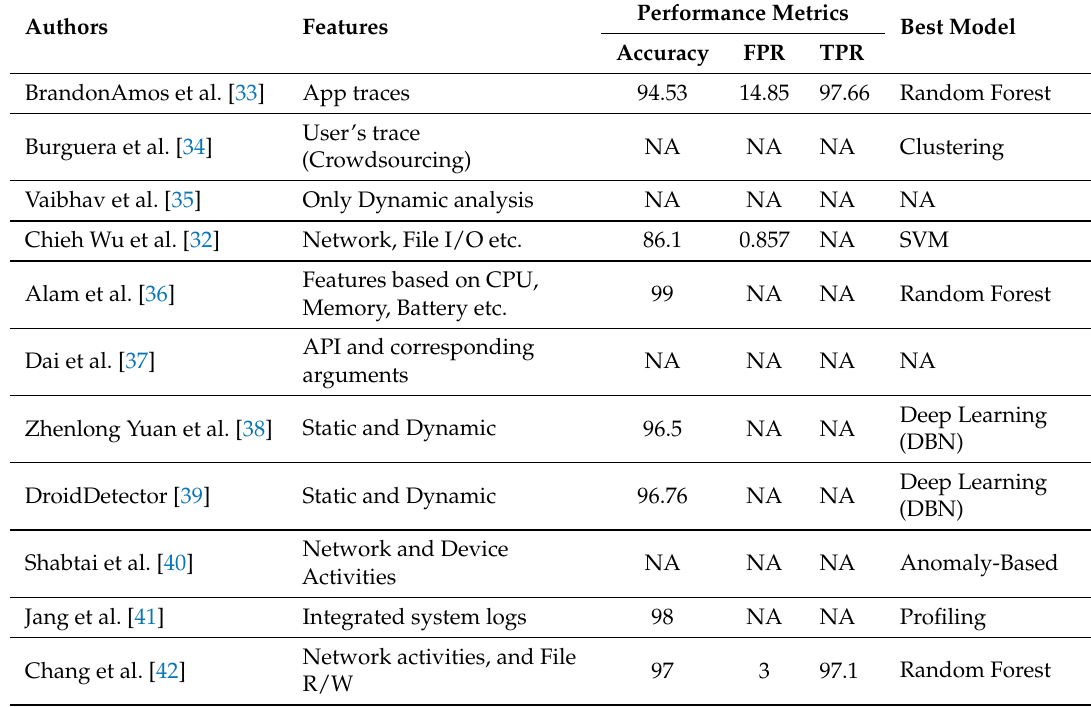
Table 3. Android Malware Detection Using Dynamic